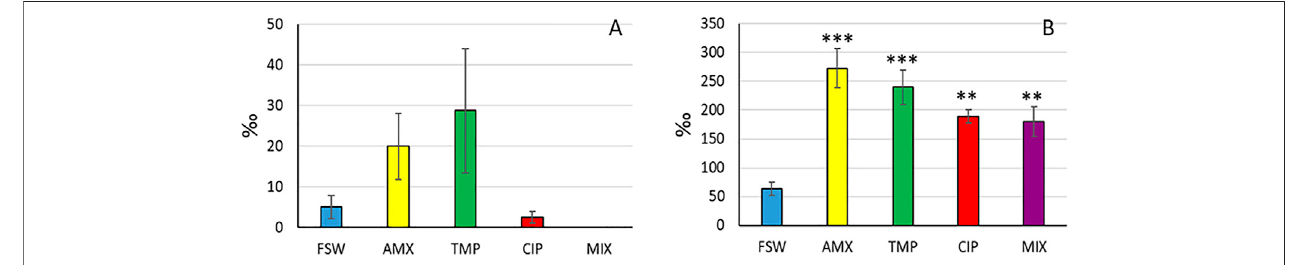
FIGURE4| Frequency ofmicronuclei (A) andchromosomalaberrations (B) inhaemocytes.Asterisksdenotesigni fi cantdifferenceswithrespecttocontrols(FSW):